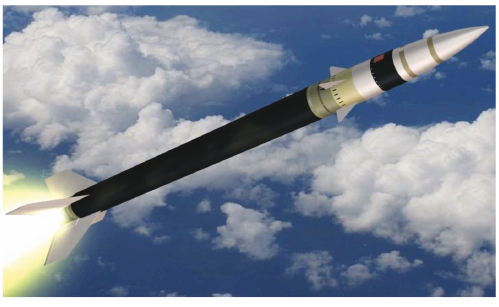
Figure 1: Black Brant VC. Table 1: “ Maxus ” and “ Black Brant VC ”